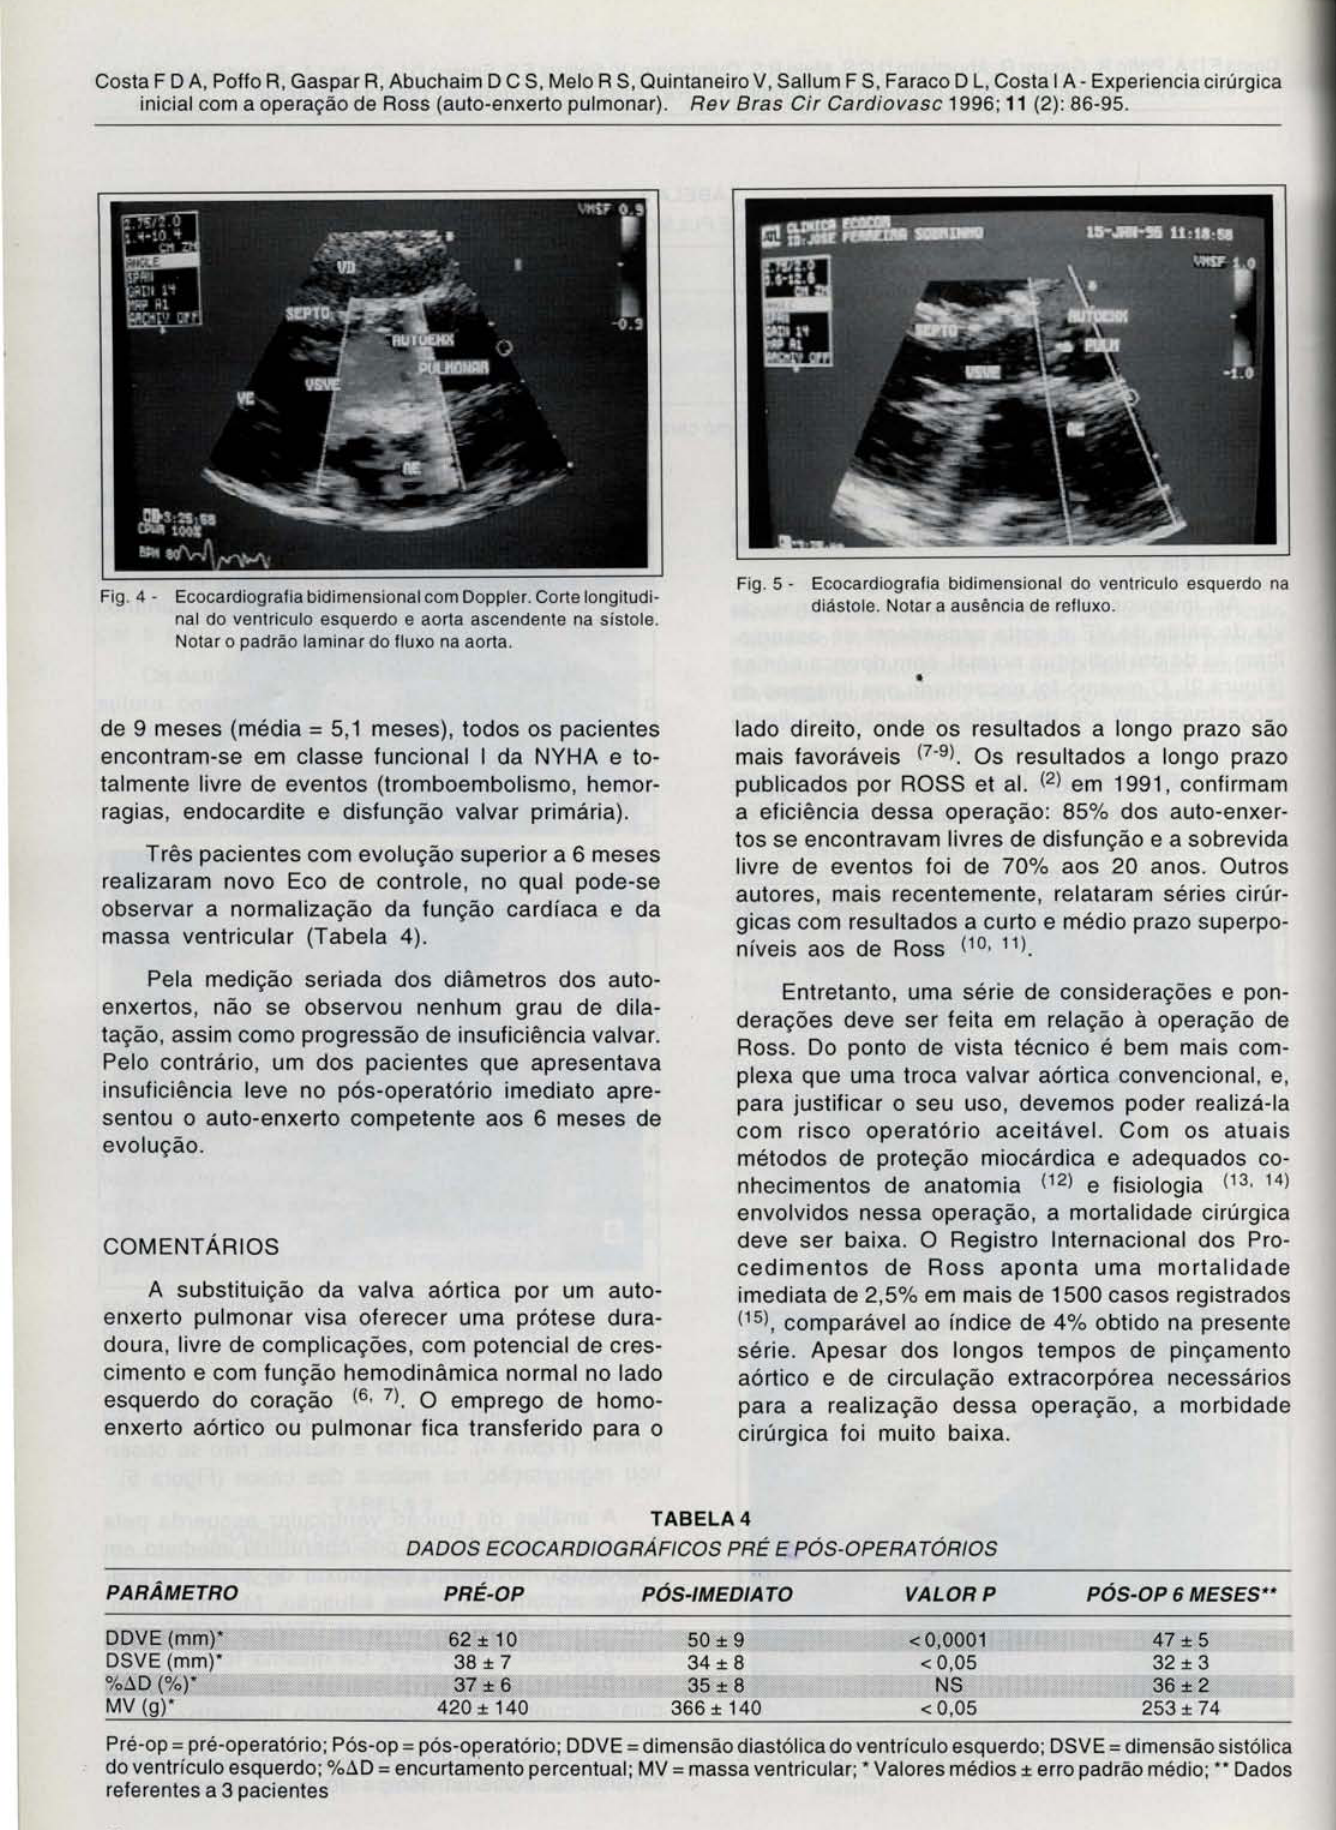
Fig. 4 - Ecocardiografia bidimensional com Doppler. Corte longitudi nal do ventriculo esquerdo e aorta ascendente na sístole. Notar o padrão laminar do fluxo na aorta.